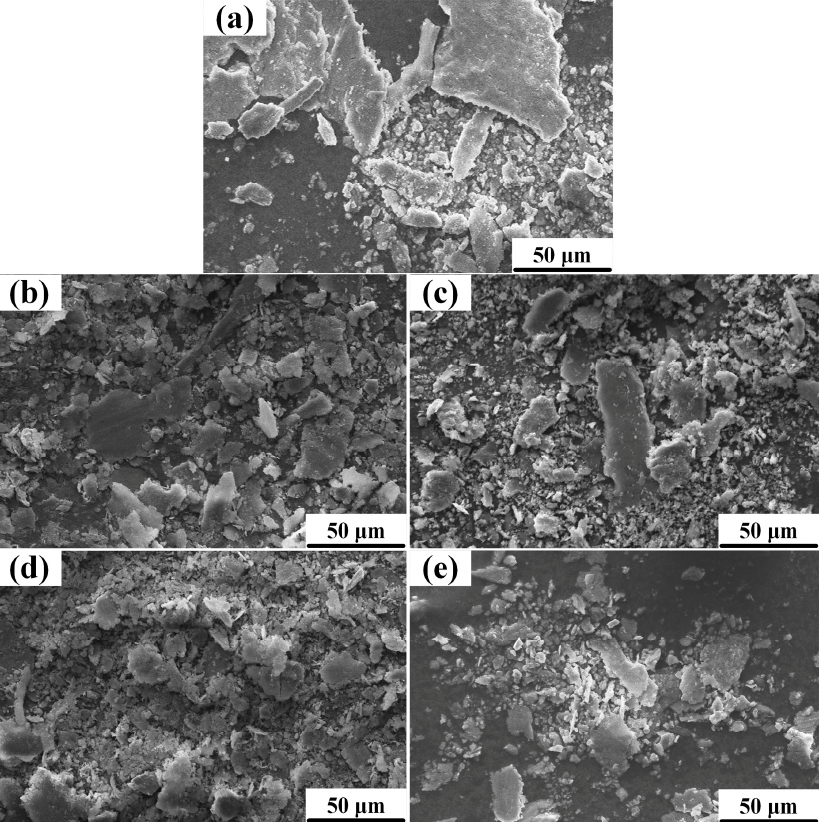
Figure 11. The wear debris morphologies of ( a ) the Al-Cu matrix alloy and Al-Cu matrix composites reinforced with different contents of micro-sized TiC p : (( b ) 1.0 wt.%, ( c ) 3.0 wt.%, ( d ) 5.0 wt.%) and ( e )